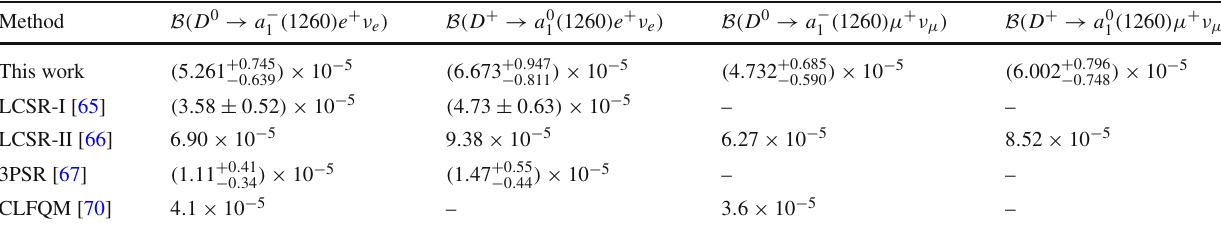
Table 6 The D → a 1 ( 1260 )(cid:4) + ν (cid:4) branching fractions with error. Other predictions are given as a